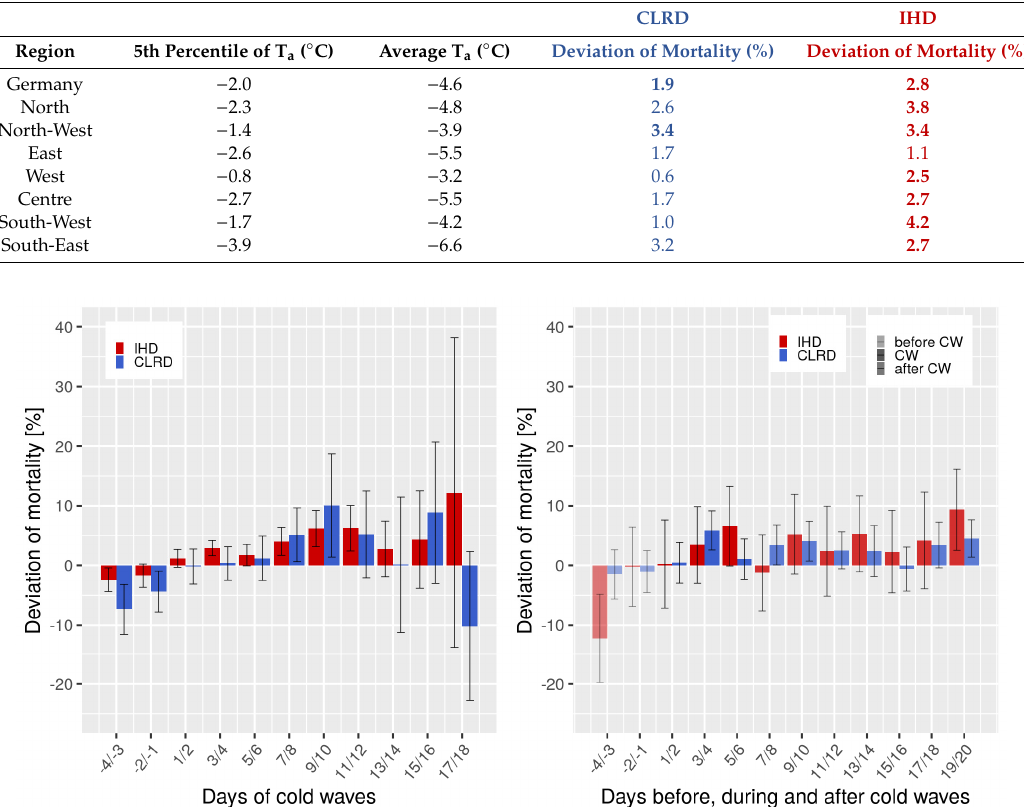
Figure 7. Deviation of CLRD and IHD mortality from the expected value due to cold waves based on T a . Left: Averaged over all cold waves between 2001–2015 in Germany. Right: Days before, during and after 6-day (3 twin-days) cold waves in Germany averaged over the years 2001–2015. Table 4. Deviation of CLRD (blue) and IHD (red) mortality during cold waves based on T a . Significant deviations on 95% level (a < 0.5) are marked in bold.